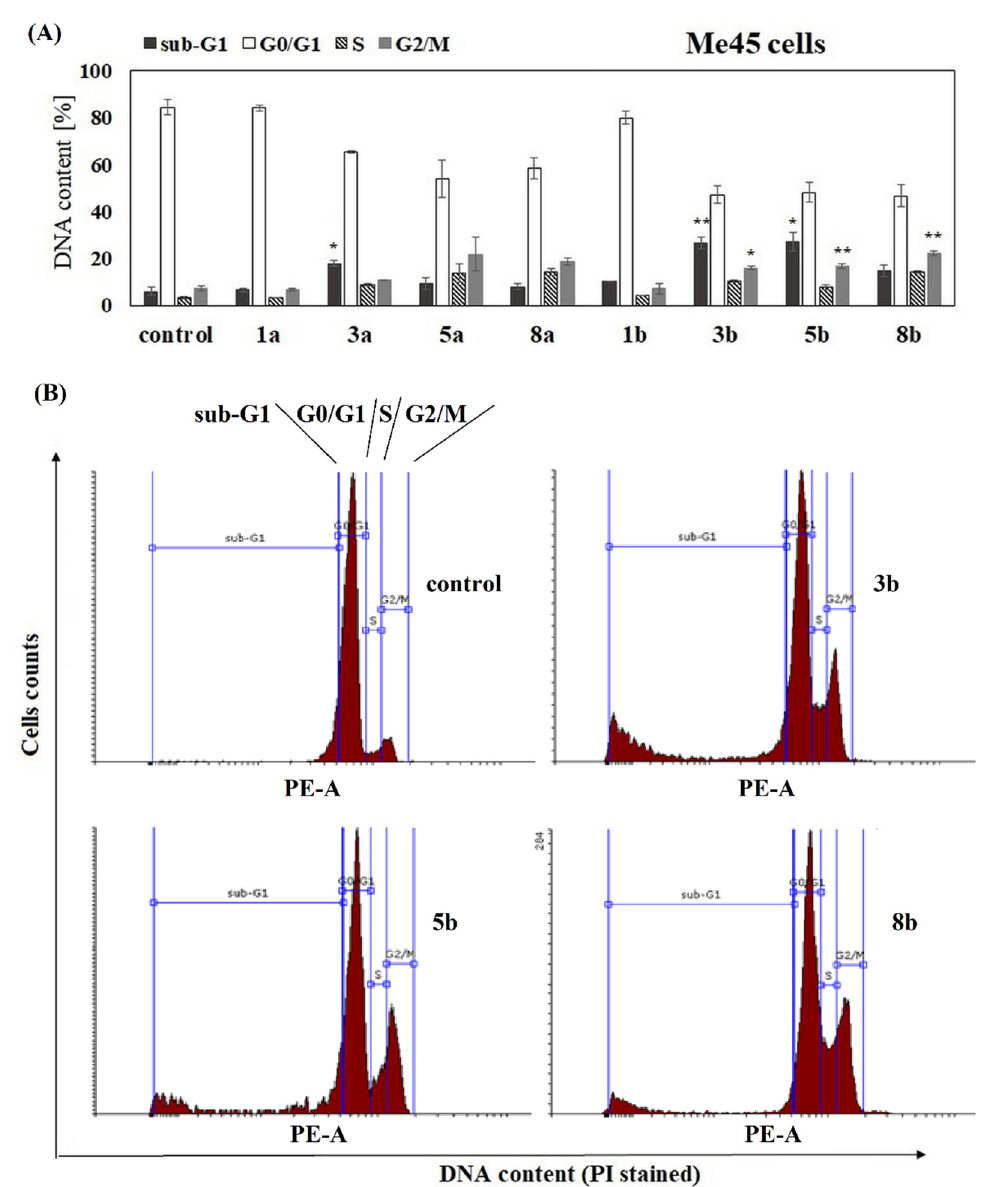
Figure 5. The distribution of Me45 cells in major phases. Cells were cultured for 72 h in the presence of the studied chemicals at a concentration of 100 µ M. The statistical significance was determined (* p < 0.05 and ** p < 0.001) ( A ). Representative histograms for effects obtained in Me45 cell line are shown ( B ).